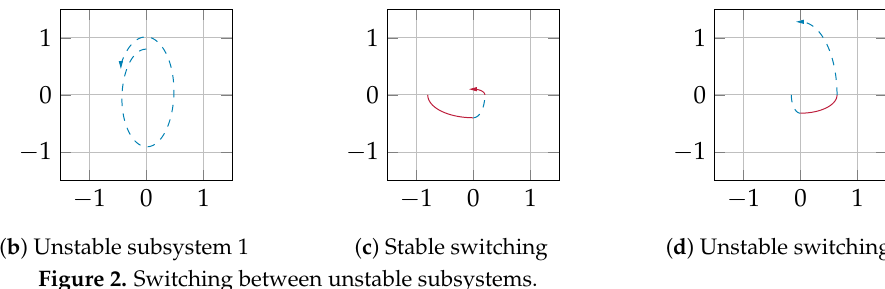
Figure 2. Switching between unstable